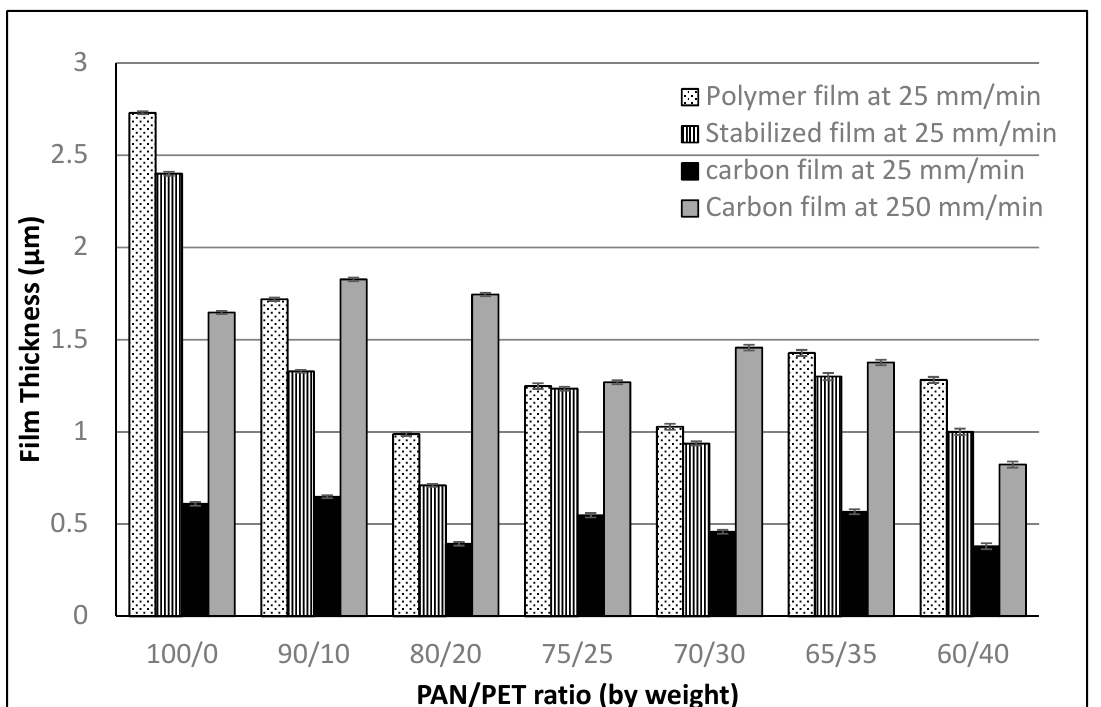
Figure 3. The thicknesses of the deposited polymer films, stabilized films, and carbon films.